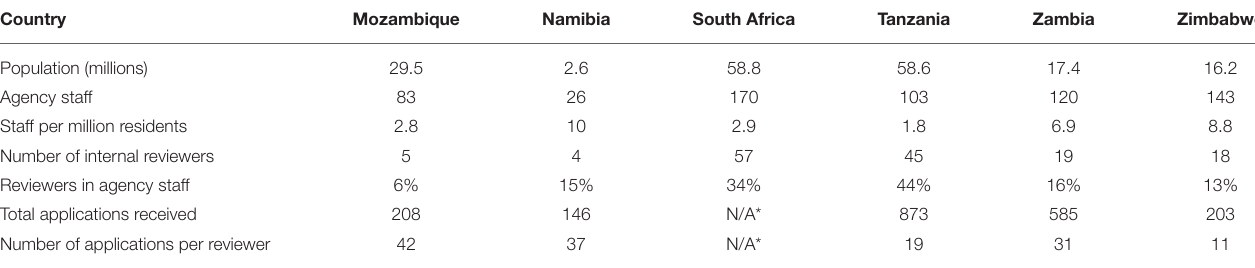
TABLE 1 | Comparison of the country population, size of agencies and workload in 2019. Country